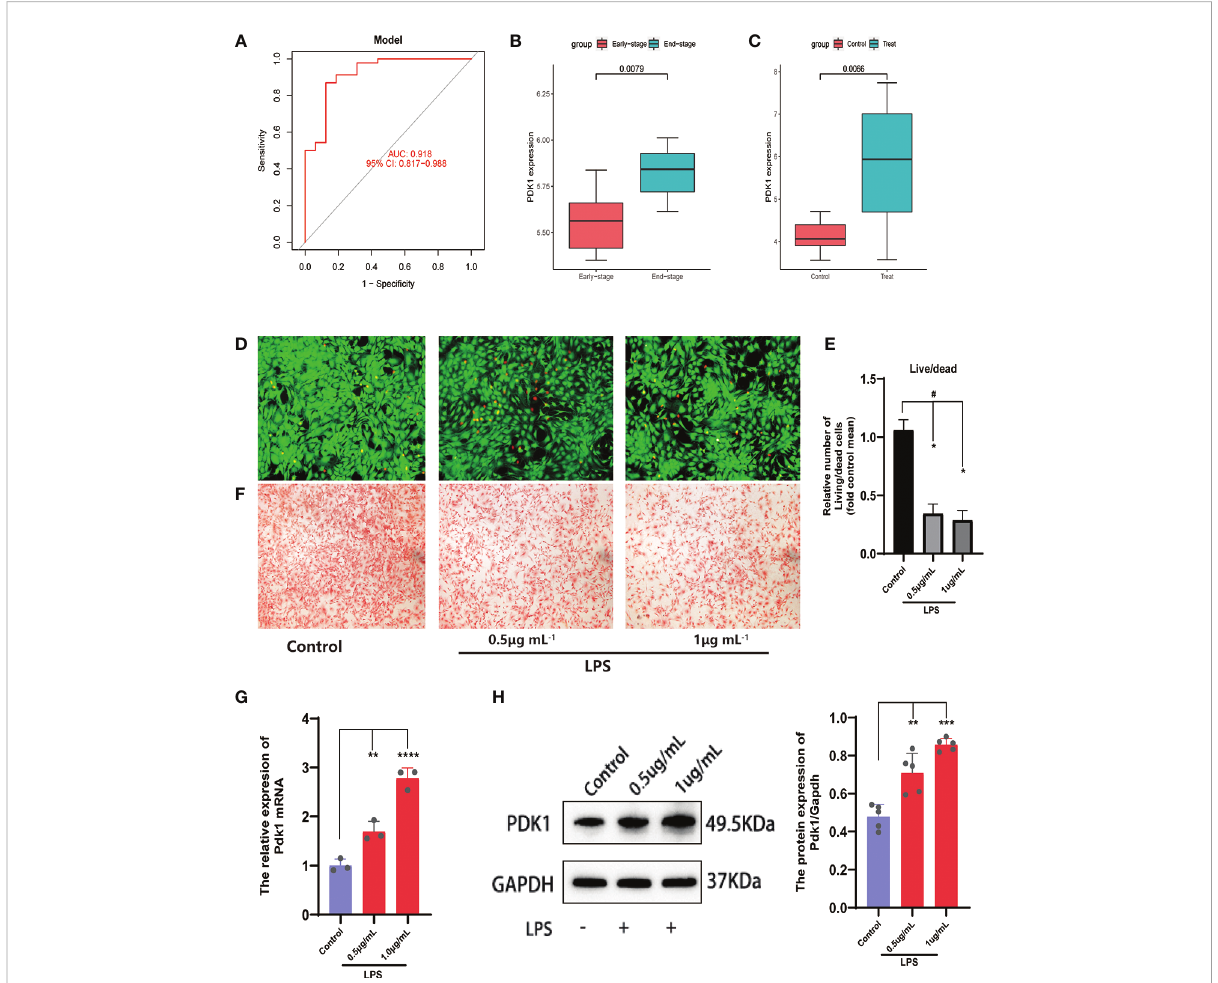
FIGURE 5 Analysis and validation of differential expression of the feature gene PDK1. (A) The ROC curve of the signature genes model for predicting disease. (B, C) Differential expression analysis of PDK1 in the (B) GSE55457and (C) GSE32317 cohorts. In the OA cell model, (D) Calcein-AM/PI staining was used to observe cell viability and (E) quantitative analysis. Chondrocytes in the control group were left untreated and were induced with 0.5 and 1 m g/mL LPS in the LPS group (means ± SD, n=3, * P <0.05, signi fi cantly different with control; # P <0.05, signi fi cantly different as indicated). (F) Safranin O for GAG production. (G, H) The relative expression of PDK1 mRNA (G) and protein expression levels (H) between OA and normal chondrocytes in the LPS group. Values are presented as means ± SD (n ≥ 3). ** p < 0.01; *** p < 0.001; **** p < 0.0001, relative